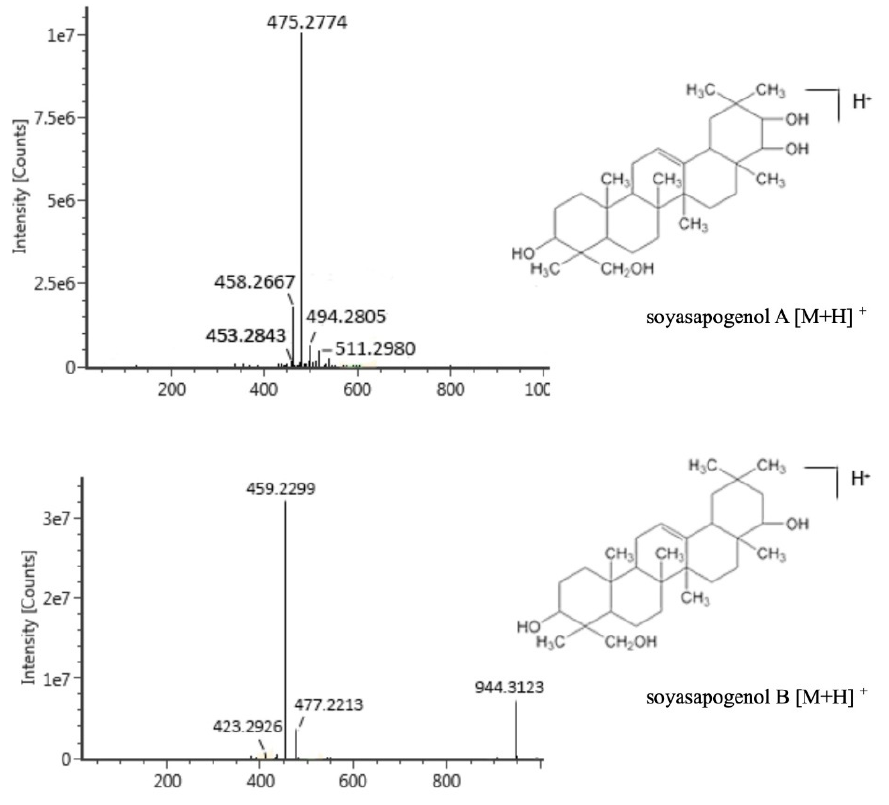
Figure 1. ESI–QTOF–MS/MS spectra of soyasapogenols A and B in the positive ion mode.